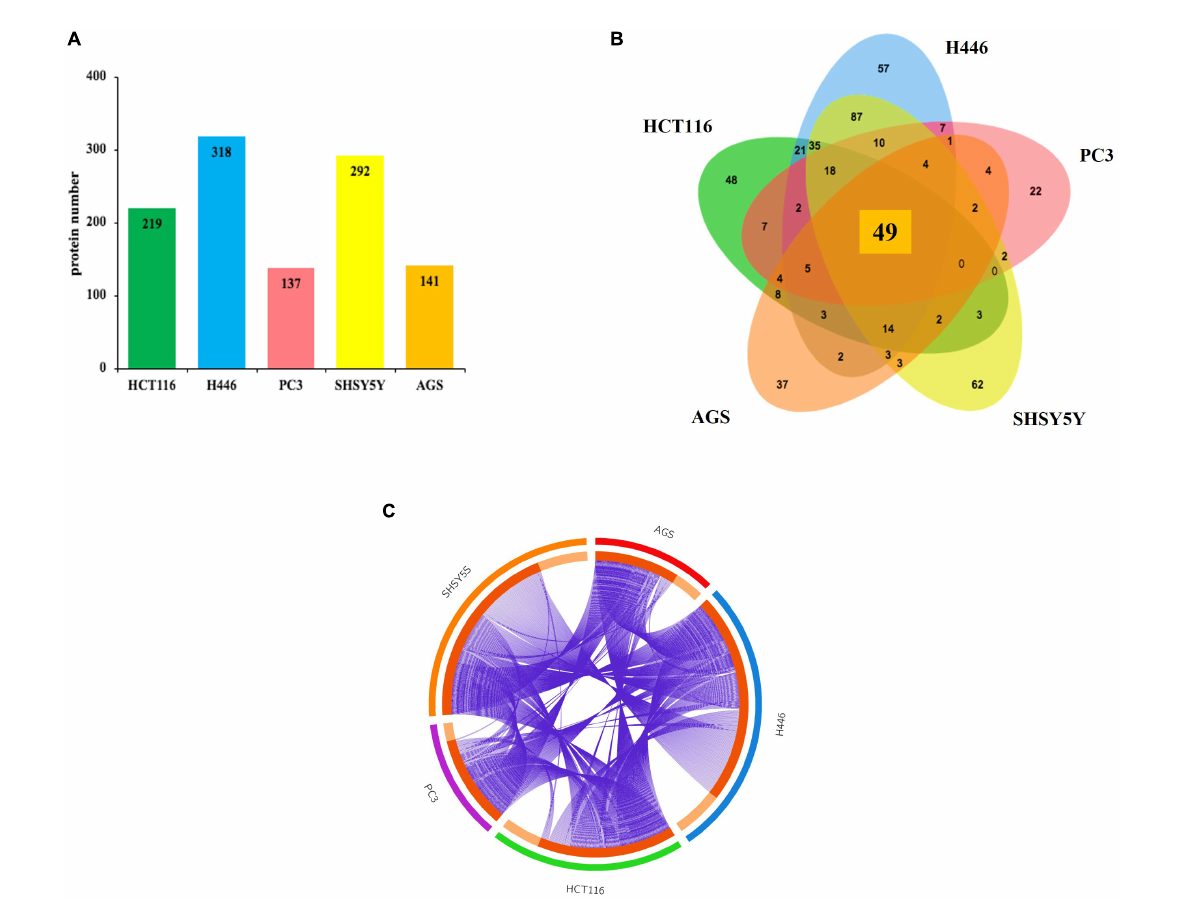
FIGURE1 Lists the total number of proteins immunoprecipitated by DnaK-V5 and identified by mass spectrometry analysis in each cell type. (A) A total of 520 proteins were identified. The histogram indicates the number of hits for each cell type. (B) A Venn diagram (http://jvenn.toulouse.inra.fr/app/example.html) visualizes the number of shared and unique proteins obtained from each cell type. Of these, 49 proteins were shared among all five human cell lines analyzed. (C) The Circos plot (Krzywinski et al., 2009) shows the overlaps between the proteins from the input lists. On the outside, each arc represents the identity of the five analyzed cell lines (red for AGS, blue for H446, green for HCT116, purple for PC3, and orange for SH-SY5Y); on the inside, each arc represents a protein list, where each protein has a spot on the arc. The dark orange color of the inside arc represents the proteins that appear in multiple cell lines and the light orange color of the inside arc represents proteins that are unique to that cell type list. Purple lines link the proteins that are shared by multiple cell type. The greater the number of purple links and the longer are the inside dark orange arcs. This implies a greater overlap among the proteins from each cell line. A full list of the total 520 isolated proteins is given in Supplementary Table 1